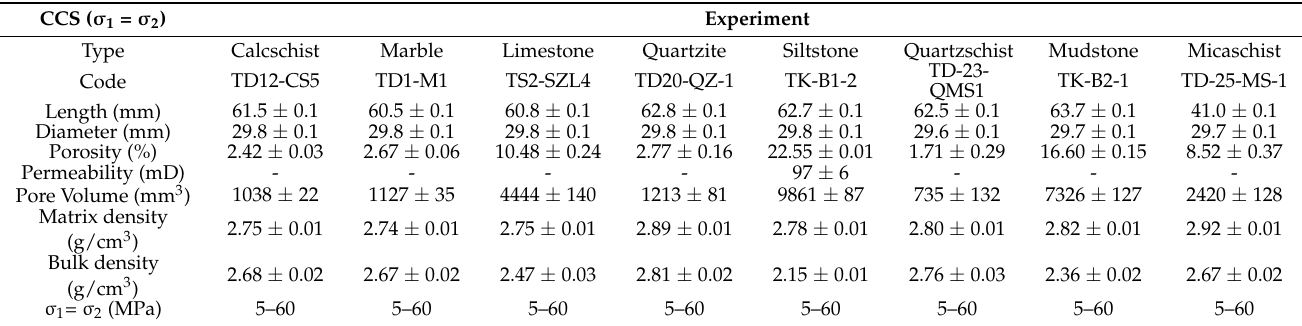
Table 3. Properties of the core samples used in experimental series B: CCS tests ( σ 1 = σ 2 ).